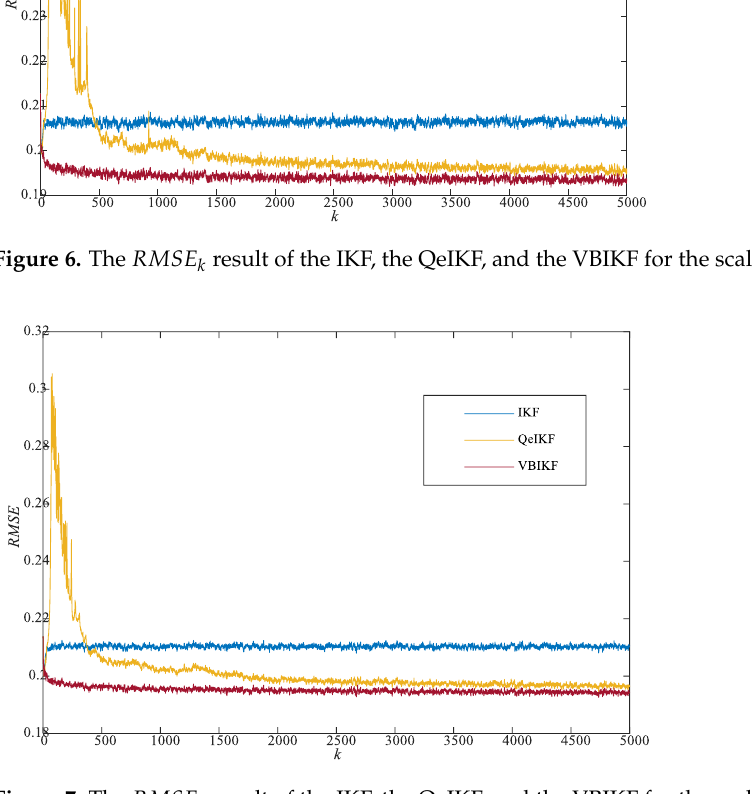
Figure 7. The RMSE k result of the IKF, the QeIKF, and the VBIKF for the scaled ˆ Σ w with α = R M S E result of the IKF, the QeIKF, and the VBIKF for the scaled ˆ Figure 7. The k 10.